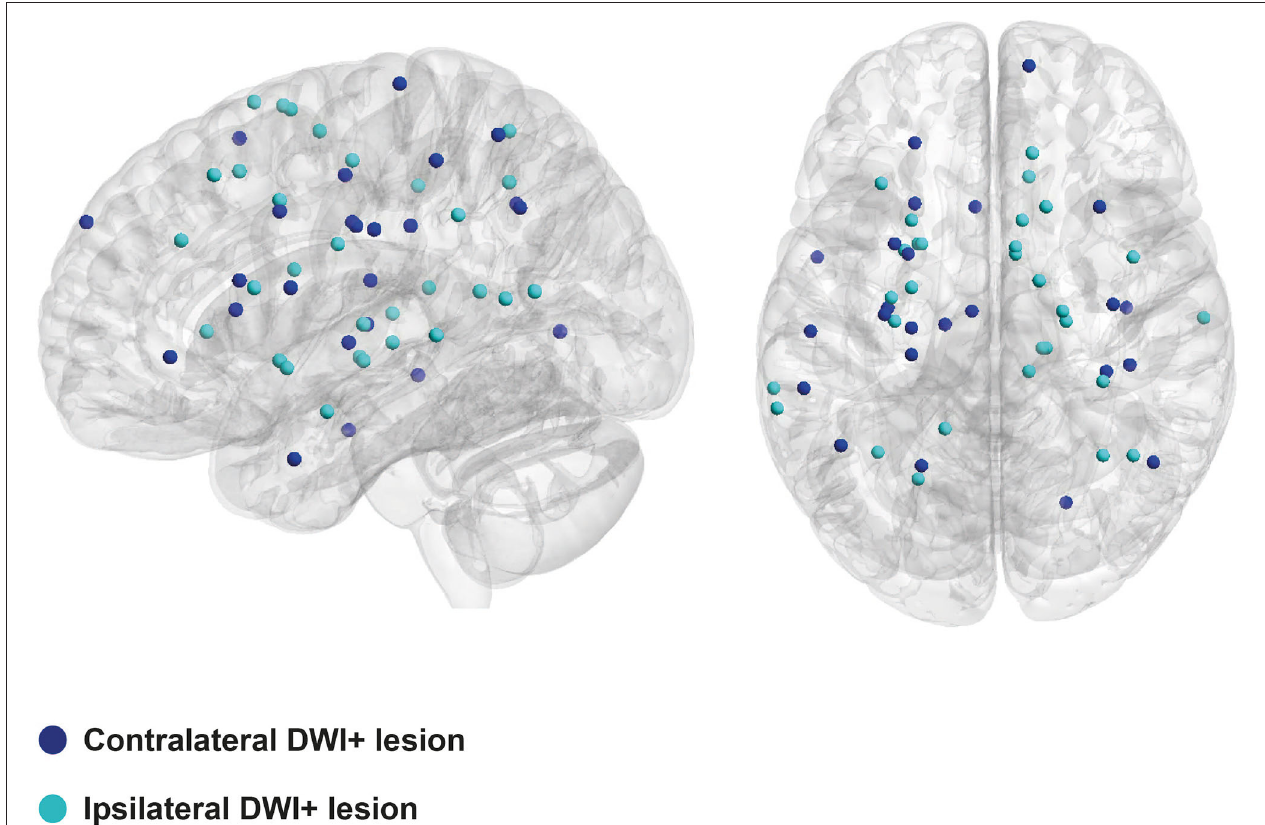
FIGURE 1 | Topographical distribution of DWI + lesions. DWI + , diffusion-weighted